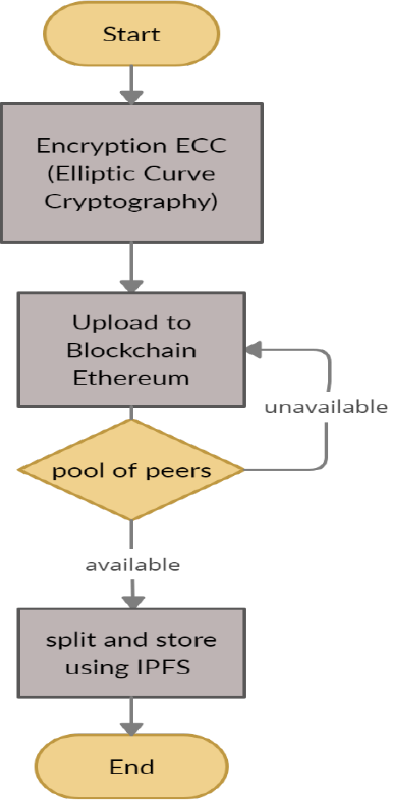
Figure 6. Flow chart of the proposed model.